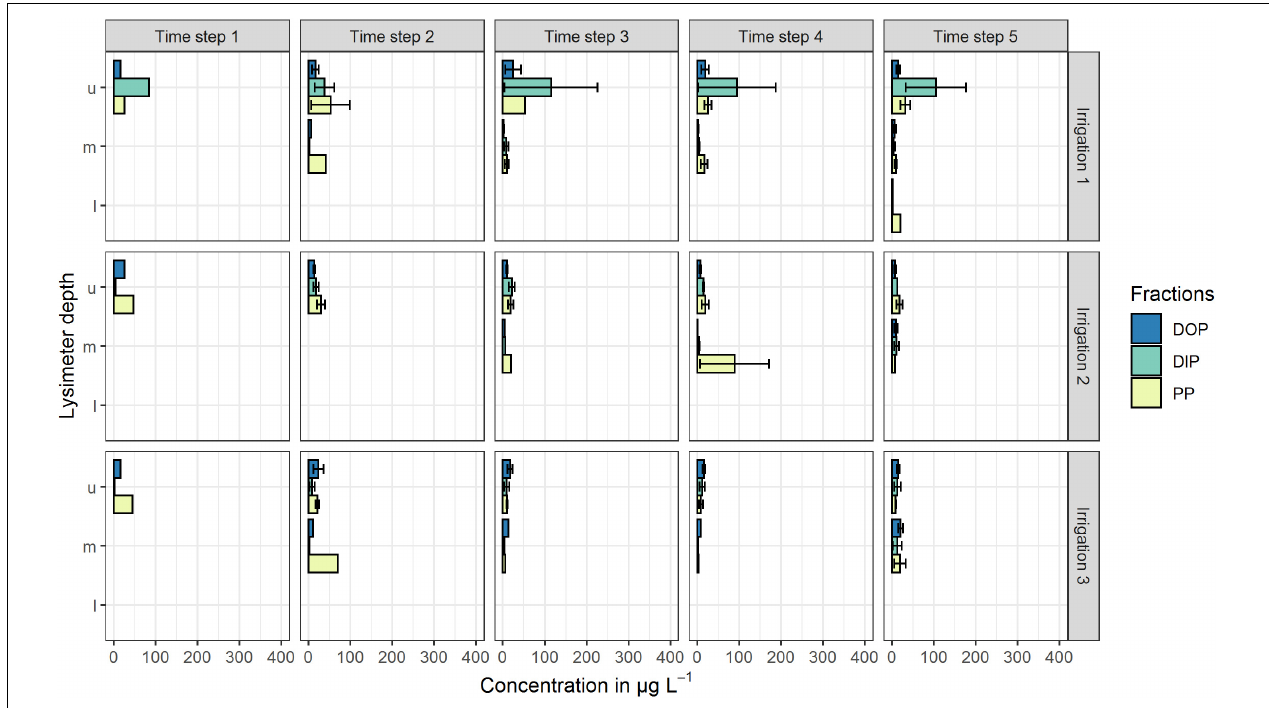
FIGURE 2 | Mean P concentrations in preferential-flow water collected with zero-tension lysimeters during three irrigations at the high P site. Arithmetic means were calculated from all samples drawn in the respective time step. Shown P fractions are DOP (dissolved organic P), DIP (dissolved inorganic P) and PP (particle bound P). Lysimeter depths were indicated by u (upper), m (middle) and l (lower). Time steps 1–4 each represent 60 min of irrigation, time step 5 represents 180 min after the end of the irrigation. No bar indicates that in the respective time step and/or depth, no sample was drawn. Error bars indicate the standard